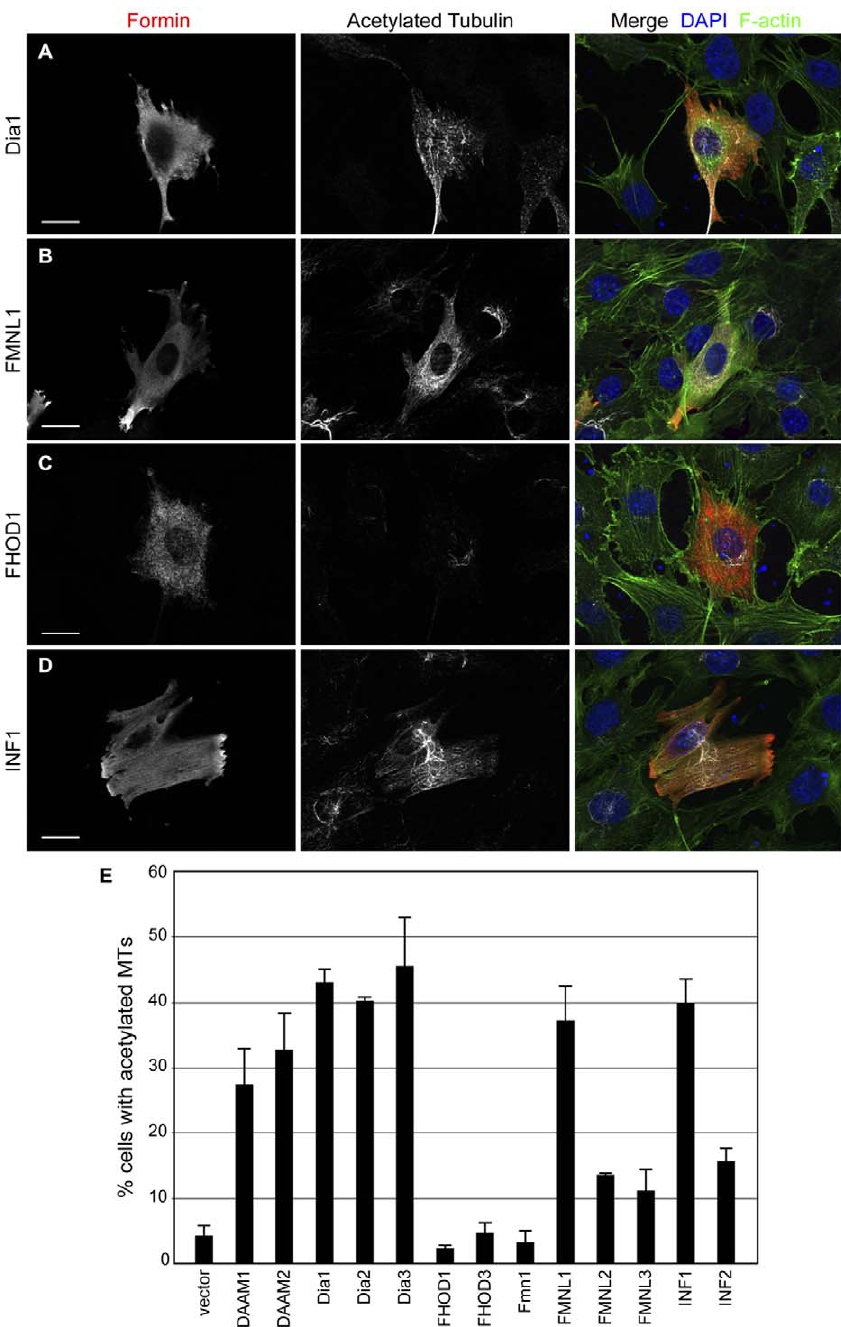
Figure 4. Microtubule acetylation induced by expression of formin FH1FH2 derivatives. FH1–FH2 containing formin derivatives were expressed in NIH 3T3 fibroblasts by transient transfection. Their effects on microtubule acetylation were assessed by immunofluorescence. A ) Expression of Dia 1 (red, left panel) induces microtubule acetylation (white, middle panel). The F-actin network is also shown in the merged image (green, right panel). B ) Expression of FMNL1 (red, right panel) induces microtubule acetylation (white, middle panel). C ) Expression of the FHOD1 FH1–FH2 derivative (red, left panel) fails to induce microtubule acetylation (white, middle panel). D ) Expression of INF1 (red, left panel) induces microtubule acetylation (white, middle panel). E ) Quantification of effects of formin FH1FH2 derivative expression on microtubule acetylation. The percent of transfected cells with increased microtubule acetylation was determined by immunofluorescence. N=5, with greater than 100 cells counted per sample. Error bars represent SEM. activity than others. Expression of DAAM1, DAAM2, Dia1, Dia2, ‘‘strong’’ acetylators. FMNL2, FMNL3 and INF2 FH1–FH2 Dia3, FMNL1 and INF1 FH1FH2 derivatives induced MT expression consistently induced MT acetylation in roughly 15% of acetylation in 30–50% of transfected cells. We classify these as transfected cells and are classified as ‘‘weak’’ acetylators. Last